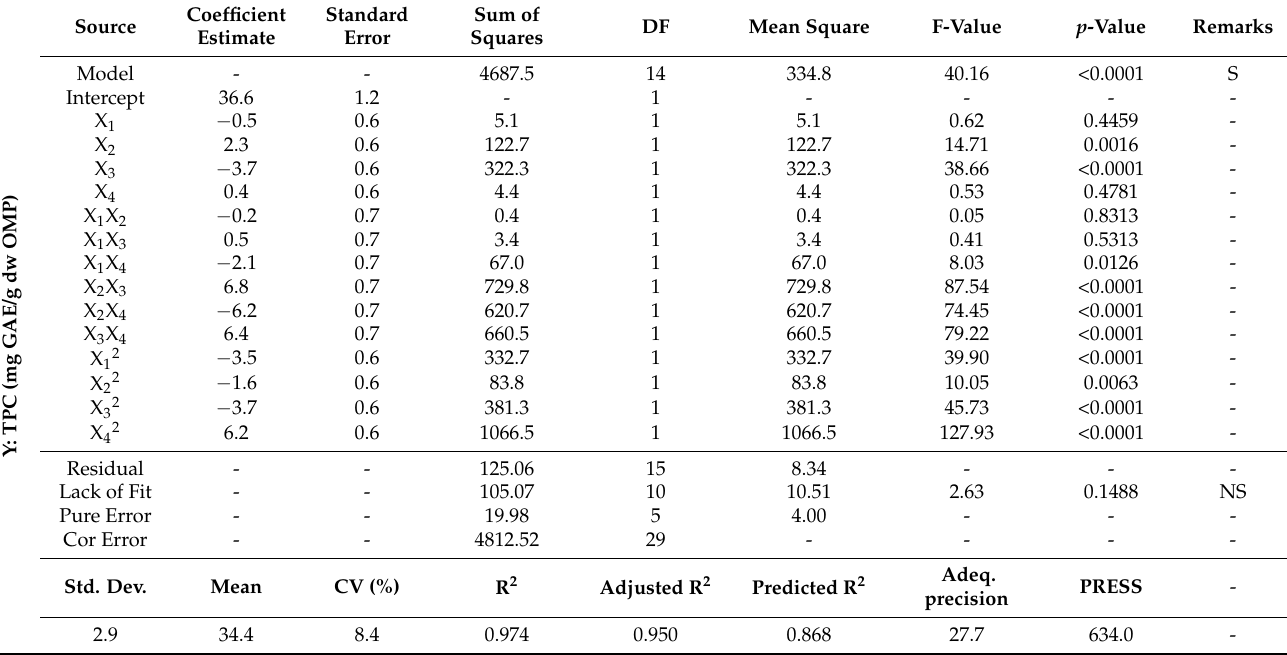
Table 3. Analysis of variance for the total phenolic content of olive mill pomace